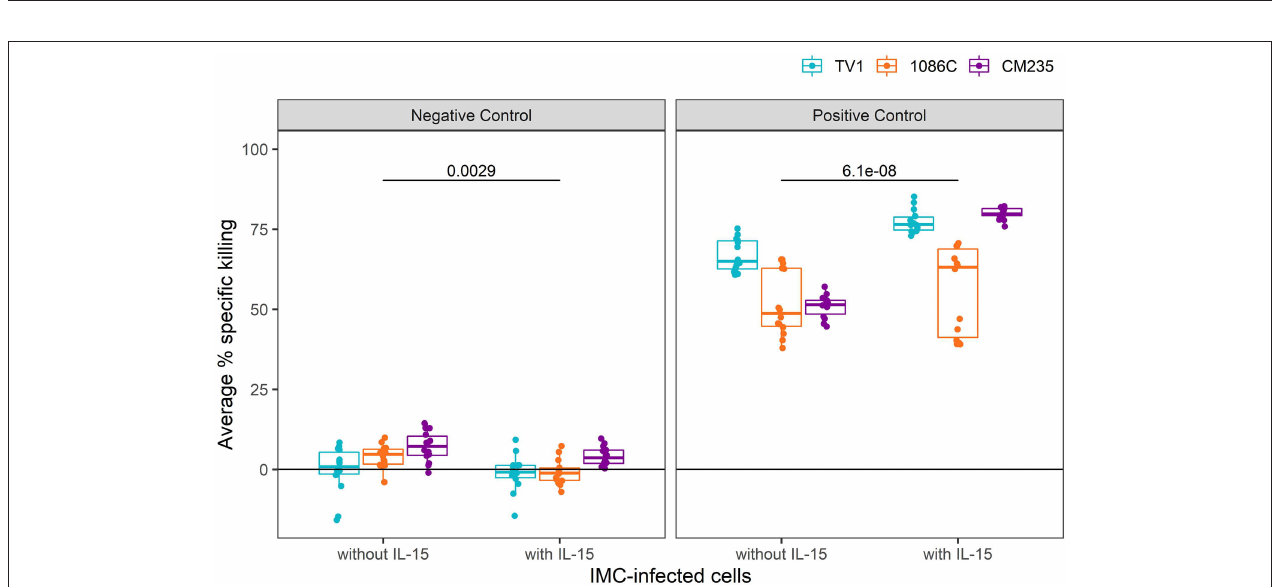
HIV-1 mAb mix positive control wells, the median